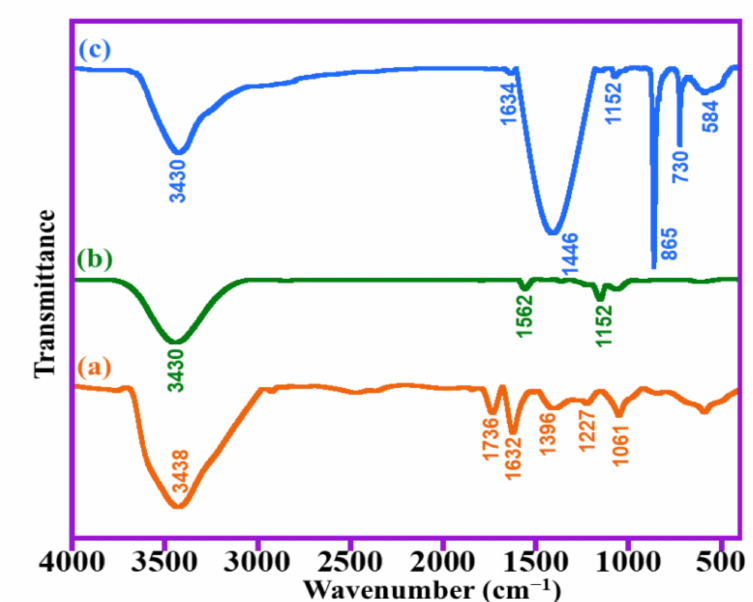
Figure 3. FT-IR results of ( a ) GO, ( b ) NDG, and ( c ) (1%)ZnO–MnCO 3 /(1%-NDG). Raman spectroscopy is an advantageous tool to study the structure of graphite deriva- tives. Figure 4 illustrates the Raman spectrum of GO, NDG, and (1%) ZnO–MnCO 3 /(1%- NDG) nanocomposites. The GO spectrum displays two eminent bands, the G-band at ~1603 cm − 1 owing to the E 2g -phonon of the sp 2 hybridization carbon atoms, and the D- band at ~1336 cm − 1 related to the breathing modes of k point phonons of A 1g -symmetry. The G-band is usually associated with the well-ordered structure of C–C bond stretching vibrations [55]. The D-band originates from the disorder structure, which could be due to the existence of defects like grain-boundaries, vacancies, and amorphous carbon atoms [56]. Disorder is calculated by the ratio between the intensities of D-band ( I D ) and G-band ( I G ) i.e., ( I D /I G ). For NDG and (1%) ZnO–MnCO 3 /(1%-NDG) spectra, the G-band is located at 1594 cm − 1 and 1596 cm − 1 as well as the D-band at 1327 and 1327 cm − 1 , respectively. The G-band in NDG is red shifted to a lower wavenumber because of the replacing of O atom through N-doping, which leads to the formation of pyrrolic, pyridinic, and N-graphitic instead of sp 2 carbon atoms [57]. The widened D-band in GO is attributed to the decrease in size of the sp 2 domains by the creation of defects, distortions, and vacancies upon oxidation. The increment of disorder ratio ( I D /I G ) from 1.088 (GO) to 1.324 (NDG) indicates the incorporation of heterogeneous N atoms into the graphene nanosheets. Eventually, the higher disorder ( I D /I G ) for (1%) ZnO–MnCO 3 /(1%-NDG) (1.412), compared to the pure NDG, points to the increasing of defects due to N doping